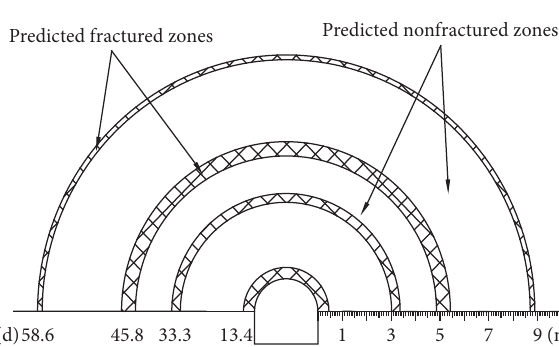
Figure 13: Distribution law of zonal disintegration in Qinling water diversion tunnel.